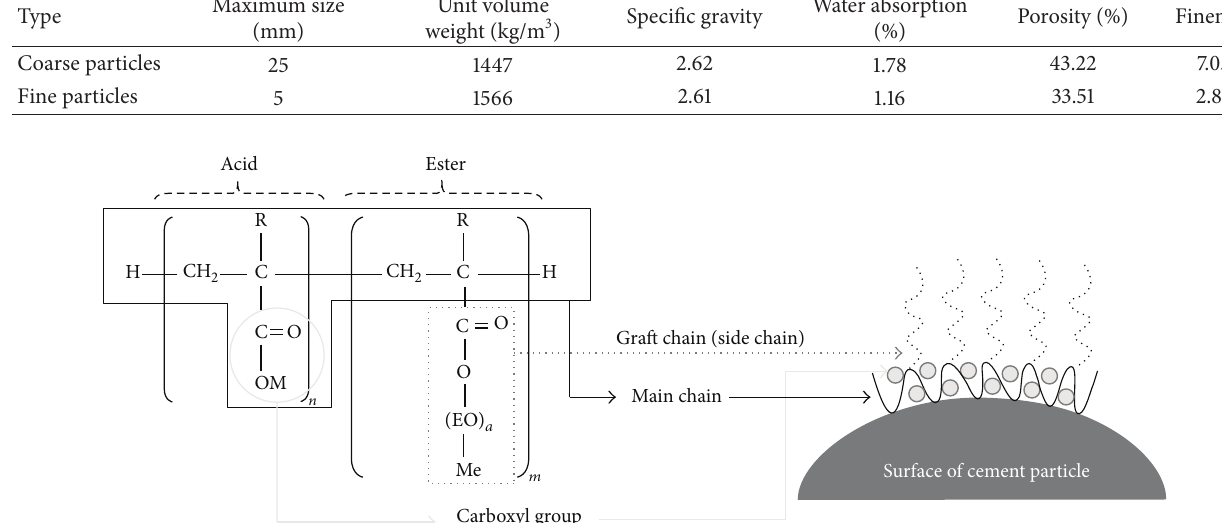
Figure 1: Molecular structure of polycarboxylate-based water-reducing agent